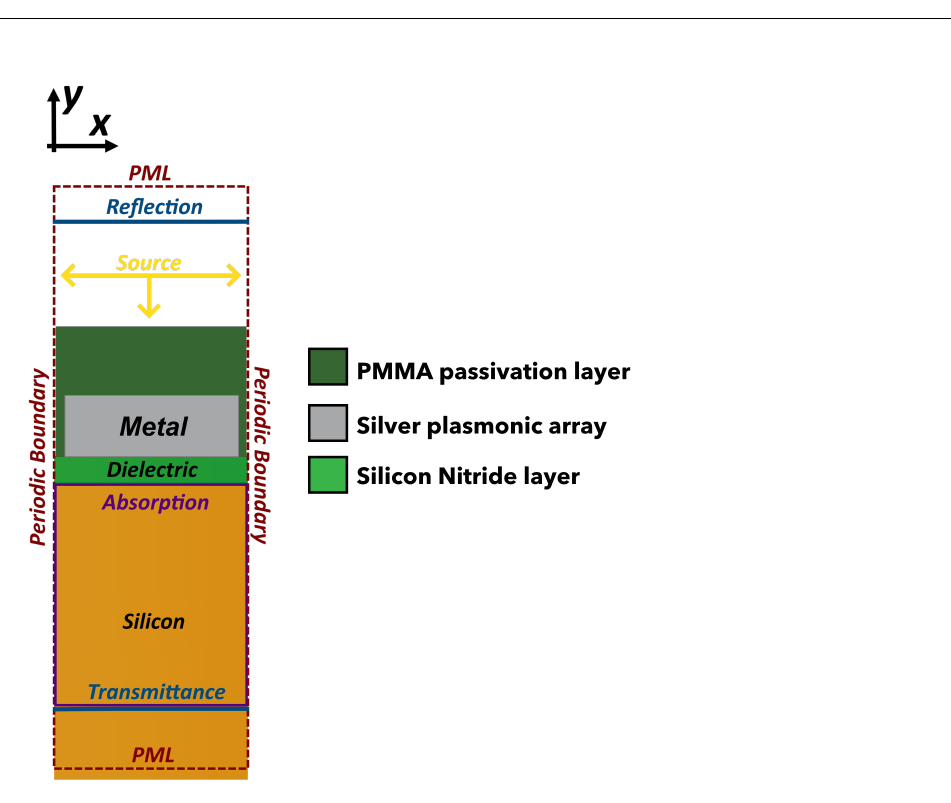
Figure 2. Cross section of the simulated structure cell with boundary conditions (red dotted line) and recording monitors (blue for reflection and transmittance, purple for absorption).